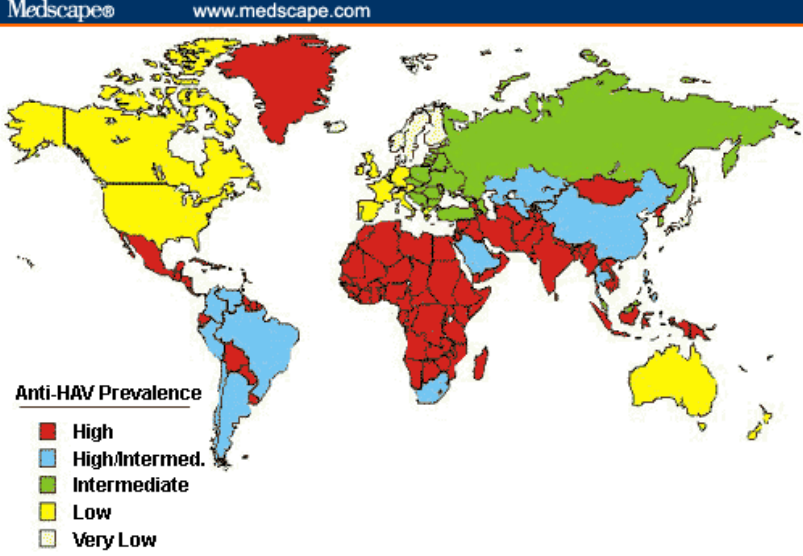
Figure 1. Global prevalence of the hepatitis A virus. Used by permission of the publisher.